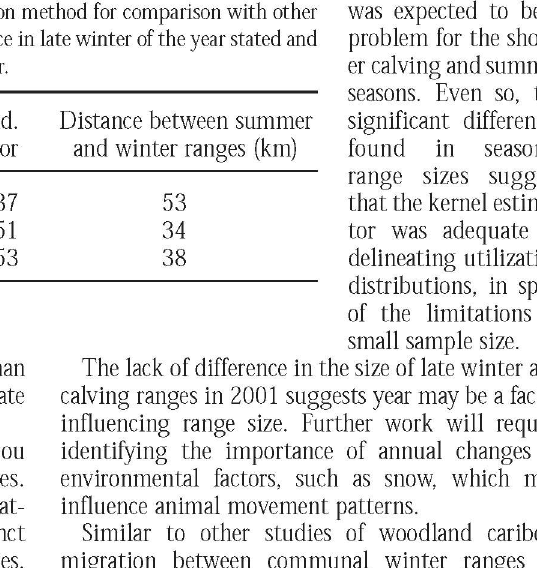
Table 1. Preliminary estimates of annual home range size (km 2 ) and seasonal movement (km) of female woodland caribou in northeastern Ontario, Canada. Ranges were calculated using the minimum convex polygon method for comparison with other studies. Each year was considered to commence in late winter of the year stated and continue to early winter of the following